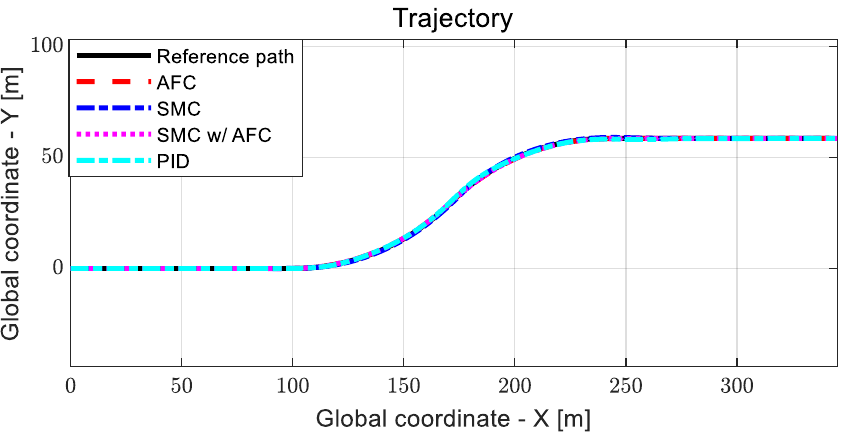
Figure 12. Results: trajectory comparison for the curved path tracking.